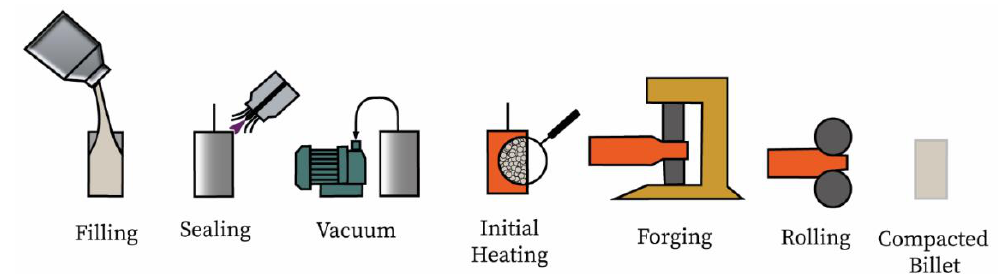
Figure 1. Presentation of the DPF sequence of operations used in the current study to achieve consolidation.